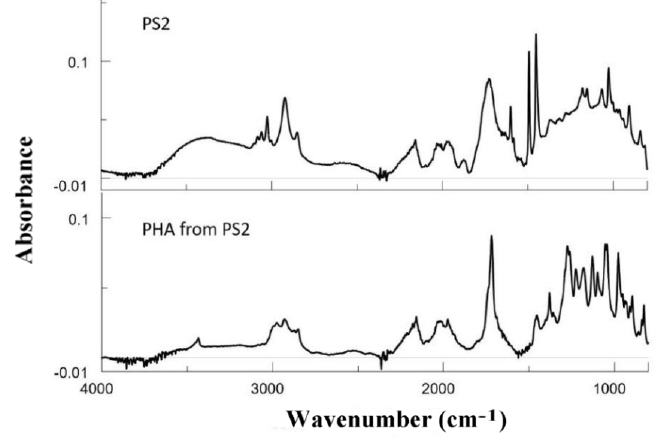
Figure 7. The comparison of the FTIR spectra of PS2 with the spectra of PHA produced from PS2 after 48 h fermentation.